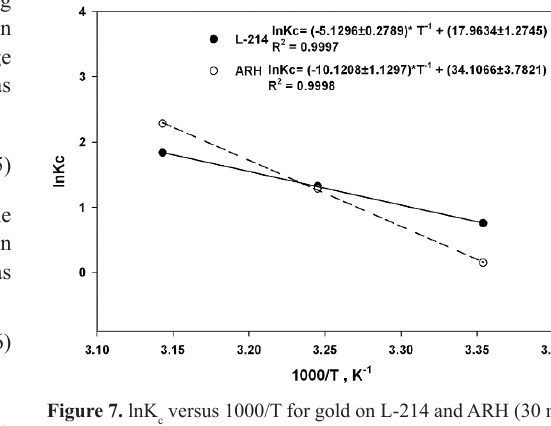
Figure 7. lnK versus 1000/T for gold on L-214 and ARH (30 mg c sorbent, 60 min, 100 rpm, pH = 6.1, C = 400 ppm, and 10 mL o